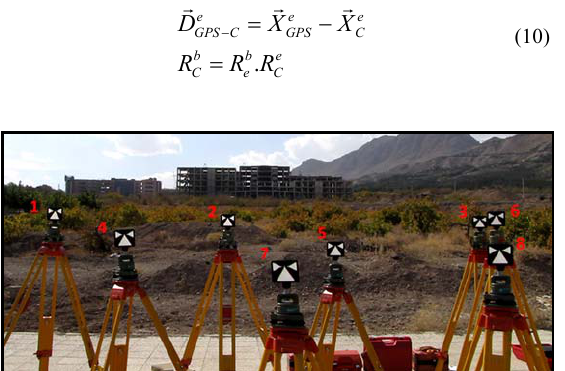
Figure 2. The pre-installed targets to calibrate the platform